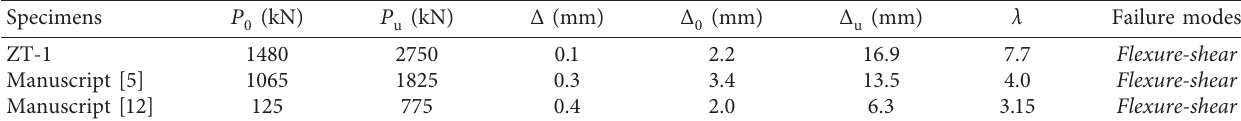
Table 4: Bearing capacity and failure modes of specimens.